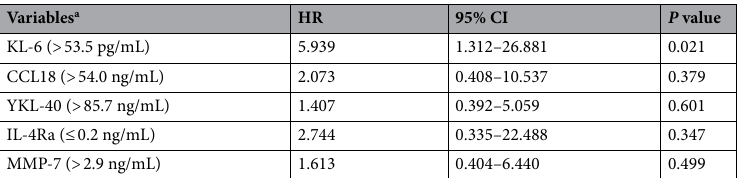
Table 4. Risk factors for mortality in patients with SJS-ILD assessed using a multivariable Cox proportional hazards model. CCL18 CC chemokine ligand 18, CI confidence interval, HR hazard ratio, IL-4Ra interleukin-4 receptor alpha, ILD interstitial lung disease, KL-6 Krebs von den Lungen-6, MMP-7 matrix metalloproteinase-7, SJS Sjögren’s syndrome, YKL-40 chitinase-3-like-1. a Adjusted by age and DL CO .